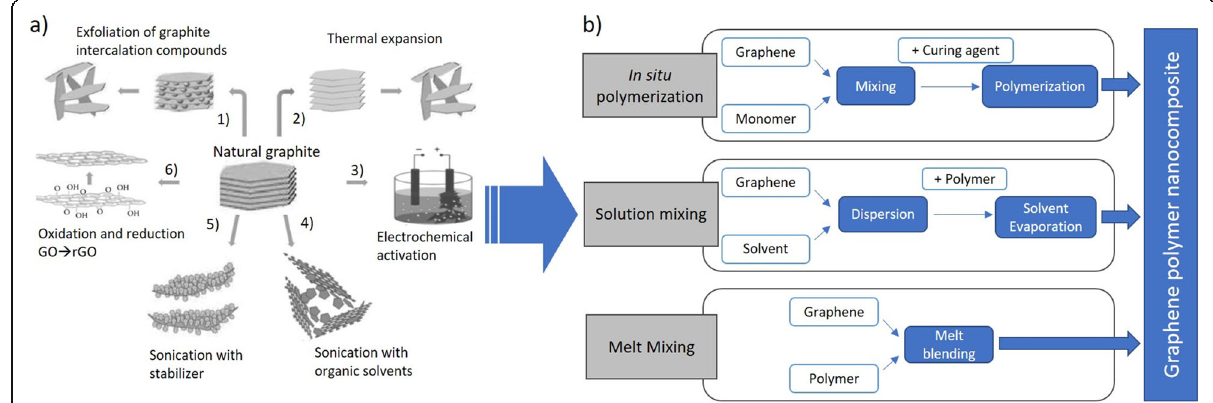
Fig. 5 Schematic representation of graphene nanocomposite production: a Preparing graphene by 1) exfoliation of graphite intercalation materials; (2) solvothermal exfoliation; (3) electrochemical activation uses an applied potential to drive exfoliation; (4) sonication in organic solvents uses direct sonication in various solvents, but without auxiliary stabilizer present; (5) sonication with stabilizer; (6) chemical oxidation to graphene oxide followed by chemical reduction back to reduced single-sheet graphene oxide; b Dispersion of graphene in the polymer matrix by melt mixing, solution mixing or in situ polymerization. Adapted from [49,